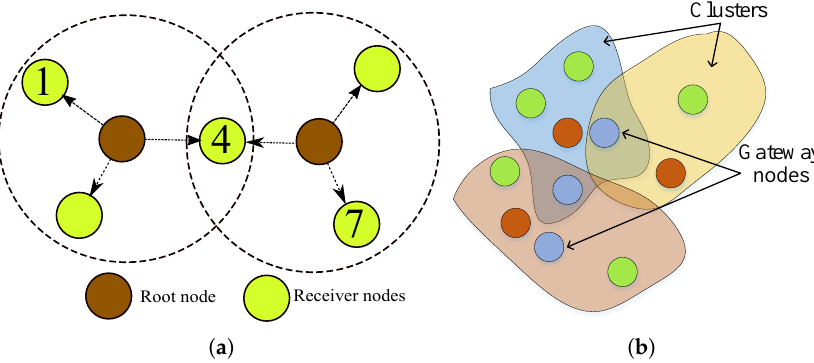
Figure 19. Multi-hop synchronization using receiver-receiver messaging scheme. In ( a ), two-hop messaging among nodes 1 and 7, which receive broadcasts from different root nodes. And in ( b ), a more general synchronization scenario of three